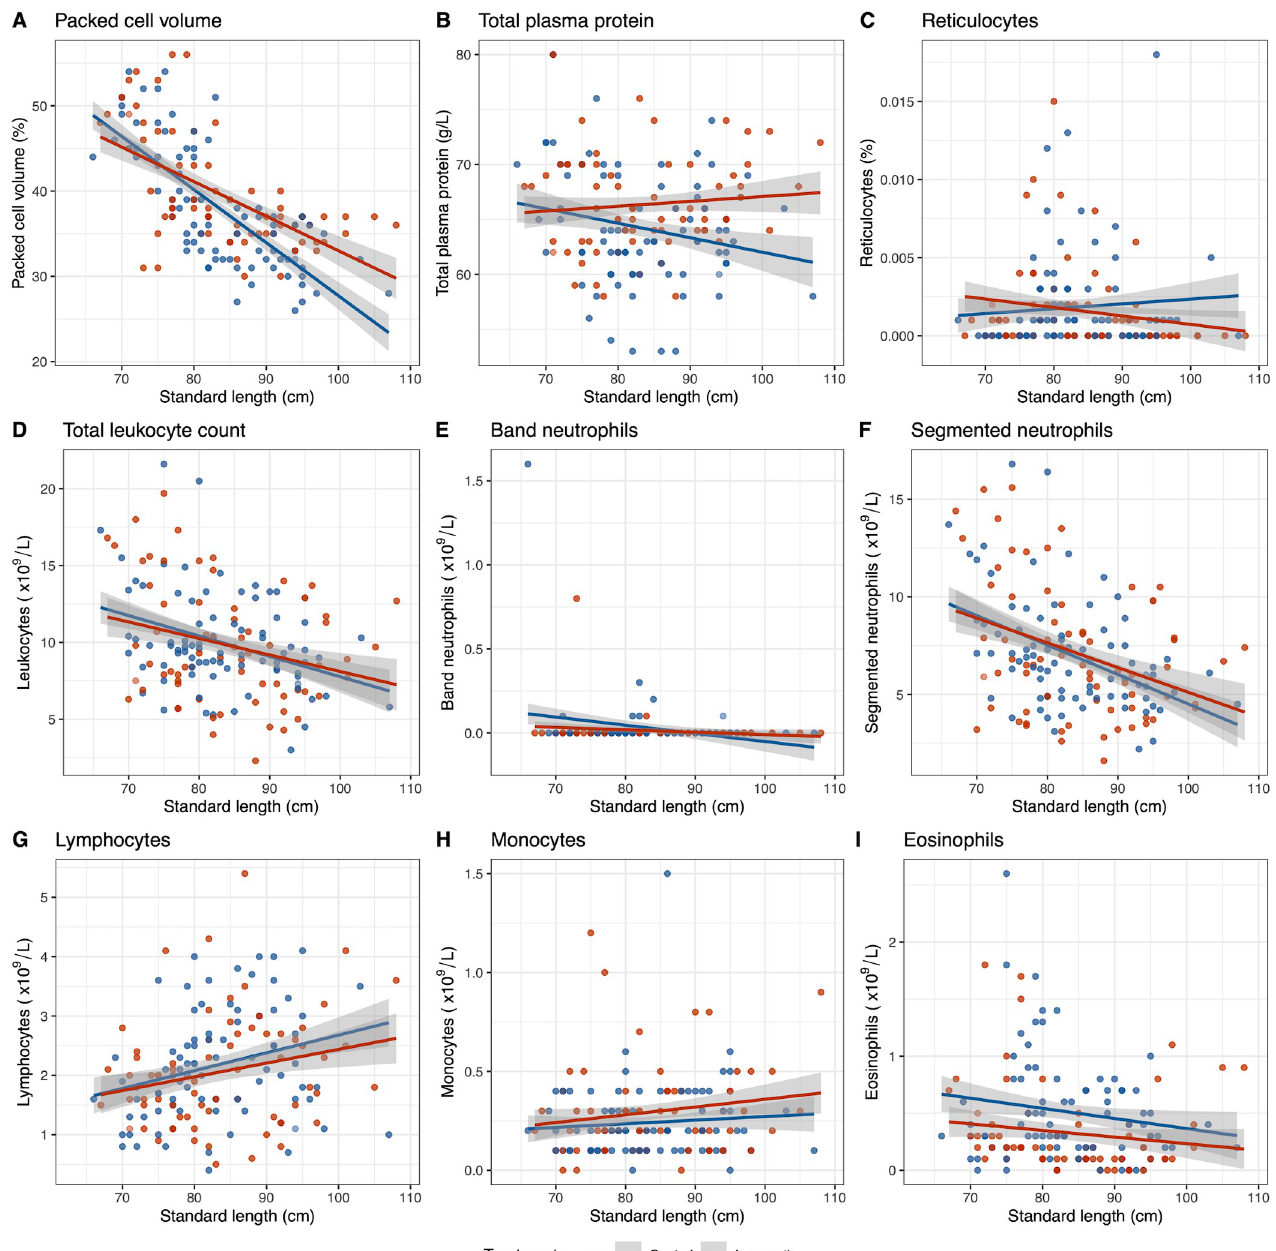
Fig 3. Line plots showing change in haematological parameters with standard length as a surrogate for age and ivermectin treatment group in New Zealand sea lion pups. Grey shading indicates 95% confidence intervals. Haematological parameters include (A) packed cell volume, (B) total plasma protein, (C) reticulocytes, (D) total leukocyte count, (E) band neutrophils, (F) segmented neutrophils, (G) lymphocytes, (H) monocytes, (I) eosinophils. packed cell volume, total leukocyte count, absolute segmented neutrophil and eosinophil counts decreasing, while absolute lymphocyte count increased with age. Ivermectin-treated pups had significantly higher TPP concentrations and significantly lower absolute eosinophil counts compared to control pups (Table 1), but treatment group did not significantly influence any other haematological parameters. Sex did not significantly influence any haematological